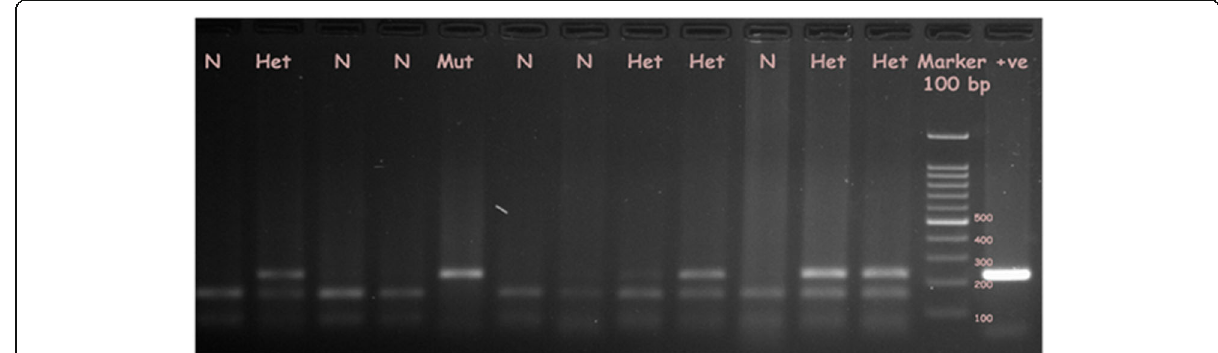
Fig. 1 Restriction digestion by Pfl F1 of SLC1A3 C3590T amplicon of representative individuals. The amplicon of SLC1A3 C3590T after digestion with the restriction endonuclese, Pfl F1, in normal condition (i.e when C is present at 3590 position) shows two fragments of DNA, 157 and 75 bp (lane 1, 3, 4, 6, 7, 10). A substitution of T in place of C, causes loss of restriction site and only one band of 232 bp (full sized amplicon; lane 5) is obtained. Heterozygotes on the other hand shows three bands of 232, 157 and 75 bp (lane 2, 8, 9, 11, 12)